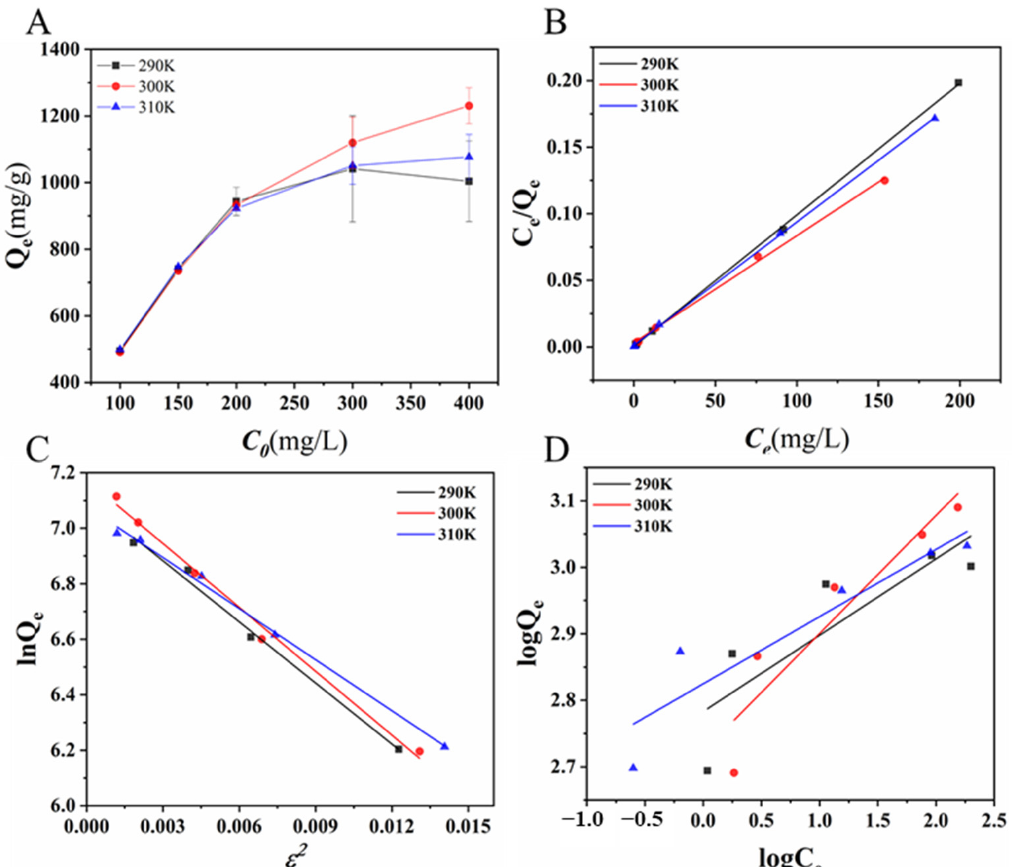
Figure 4. Effect of temperature on the N-doped CM-chitin adsorption capacity ( A ) and adsorption isotherms of CR on N-doped CM-chitin through Langmuir ( B ), Dubinin–Radushkevich ( C ), and Freundlich models ( D ).